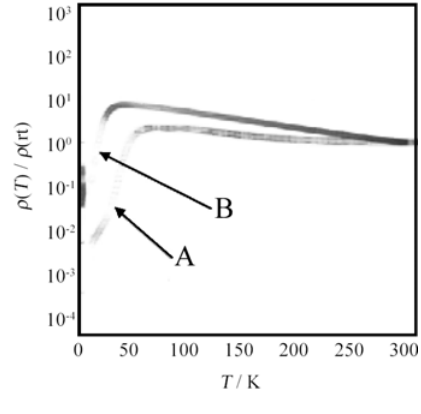
Figure 25. Temperature dependence of the normalized resistivities for the (A) bulk and (B) nano (thickness of about 100 nm, and width of about 50 μ m) crystals of •Cu[N(CN) κ− ( BEDT–TTF ) 2 2